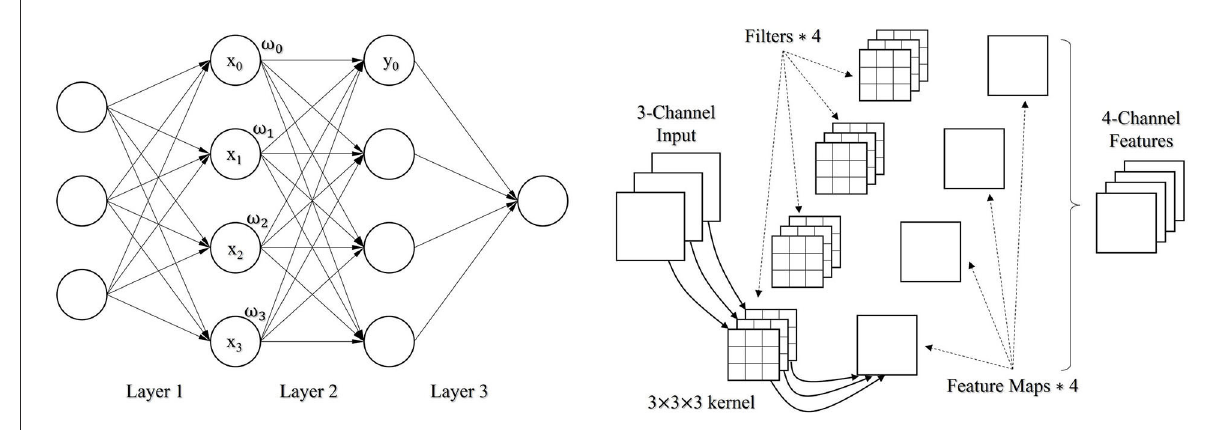
FIGURE1 A fully connected network with 3 FC layers (Left); An illustration of how a convolutional layer works